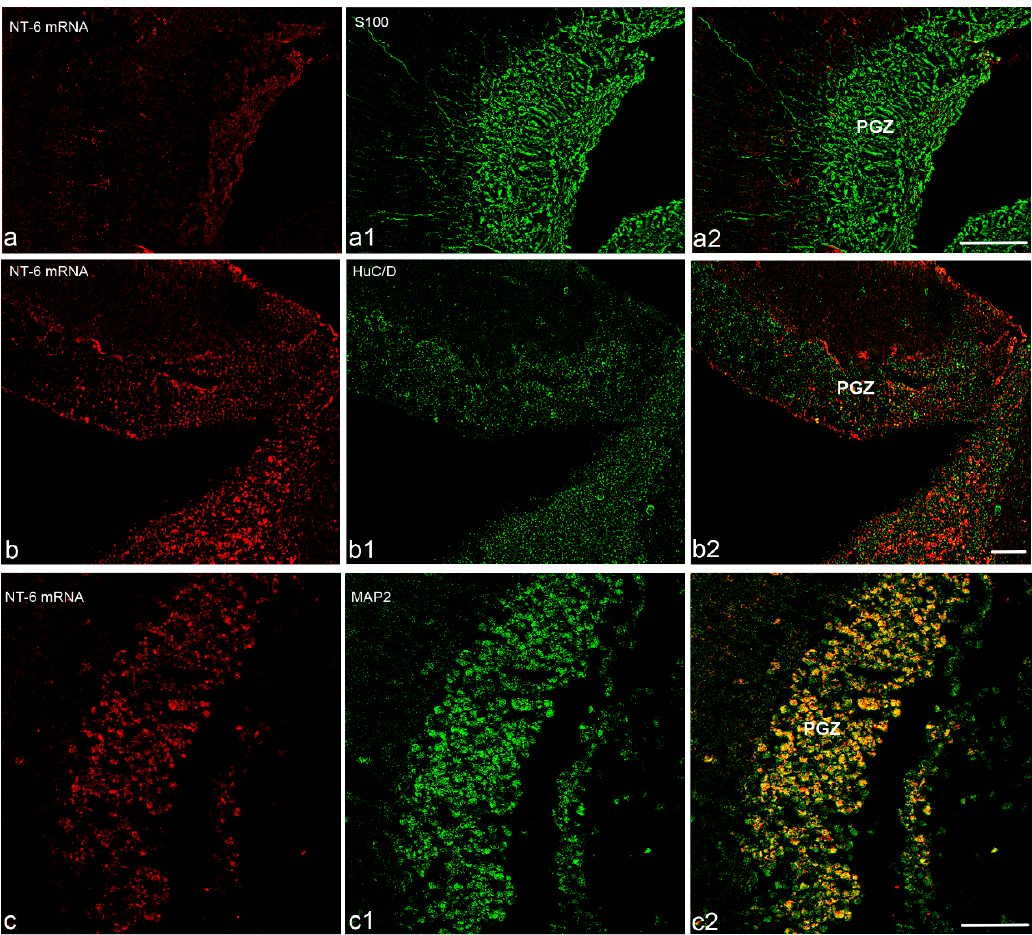
Figure 4. Immunohistochemical characterization of NT-6 mRNA expressing cells in transverse section of optic tectum: ( a , a1 , a2 ) single images and merge of NT-6 mRNA and S100 β positive cells, showing any co-staining in the rostral part of optic tectum; ( b , b1 , b2 ) single images and merge of NT-6 mRNA and HuC/HuD showing any co-staining in the rostral part of optic tectum; and ( c , c1 , c2 ) single images and merge of NT-6 mRNA and MAP2 showing that NT-6 is expressed in numerous MAP2 immunopositive. Scale bar: ( a , c ) 50 µm; and ( b ) 25 µm. Abbreviations: PGZ, periventricular grey zone.